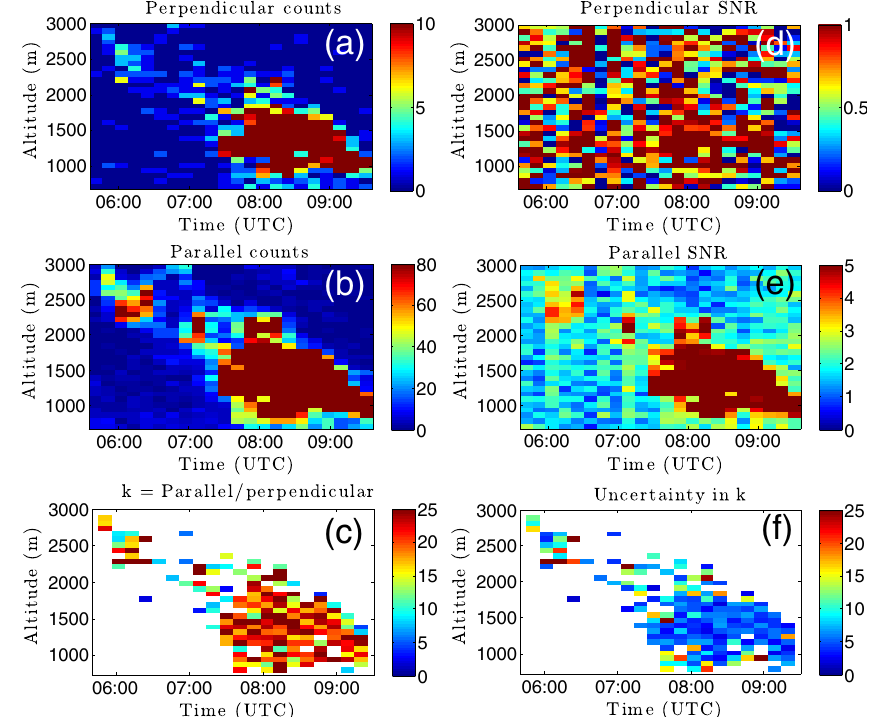
Figure 4. Parallel and perpendicular channel corrected photocounts within the calibration region of interest, with their associated signal-to- noise ratios (SNR) plotted to the right. Bottom left panel shows the ratio of the counts for each time–altitude point ( k ), with the associated uncertainties in k shown at bottom